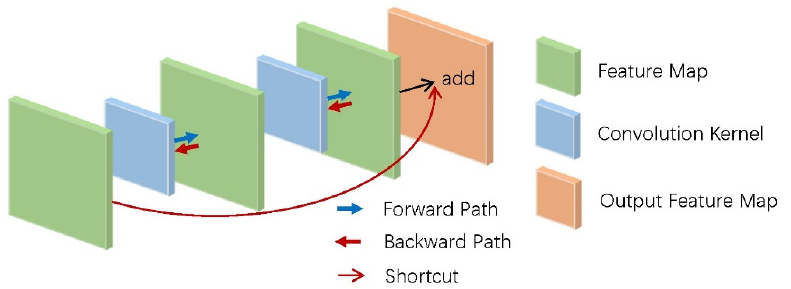
Figure 7. Structure of a basic residual block.